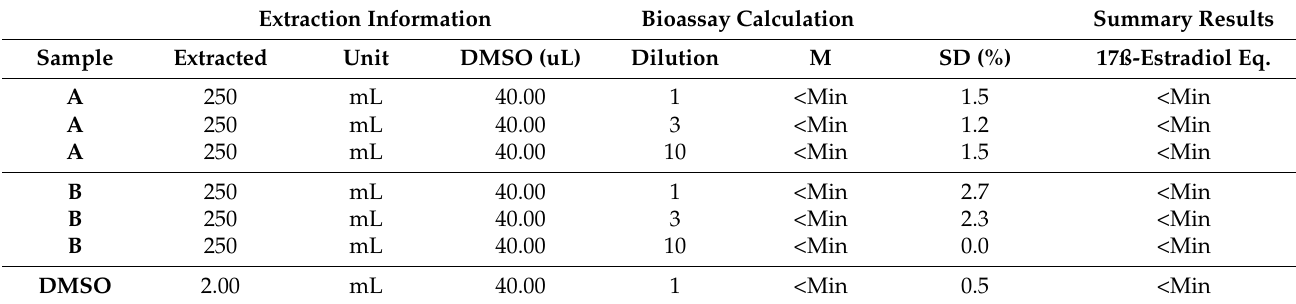
Figure 1. Calibration curve of ER-Calux ® bioassay. Graphical representation of the results from the nine calibrators. RLU (relative light unit) are units used for the luminescent measurement. Table 2. Results of the two water samples with ER-Calux ® bioassay. DMSO denotes dimethyl sulfoxide, M concentration SD standard deviation.